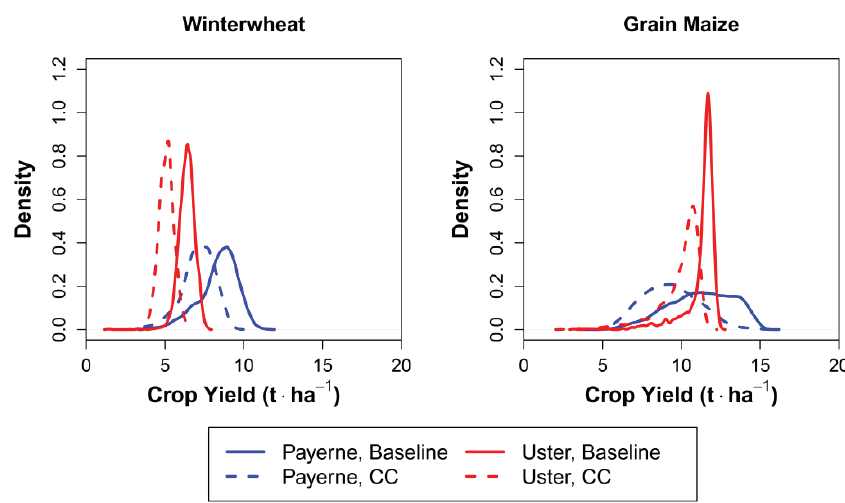
Figure 1. Simulated crop yield distributions.